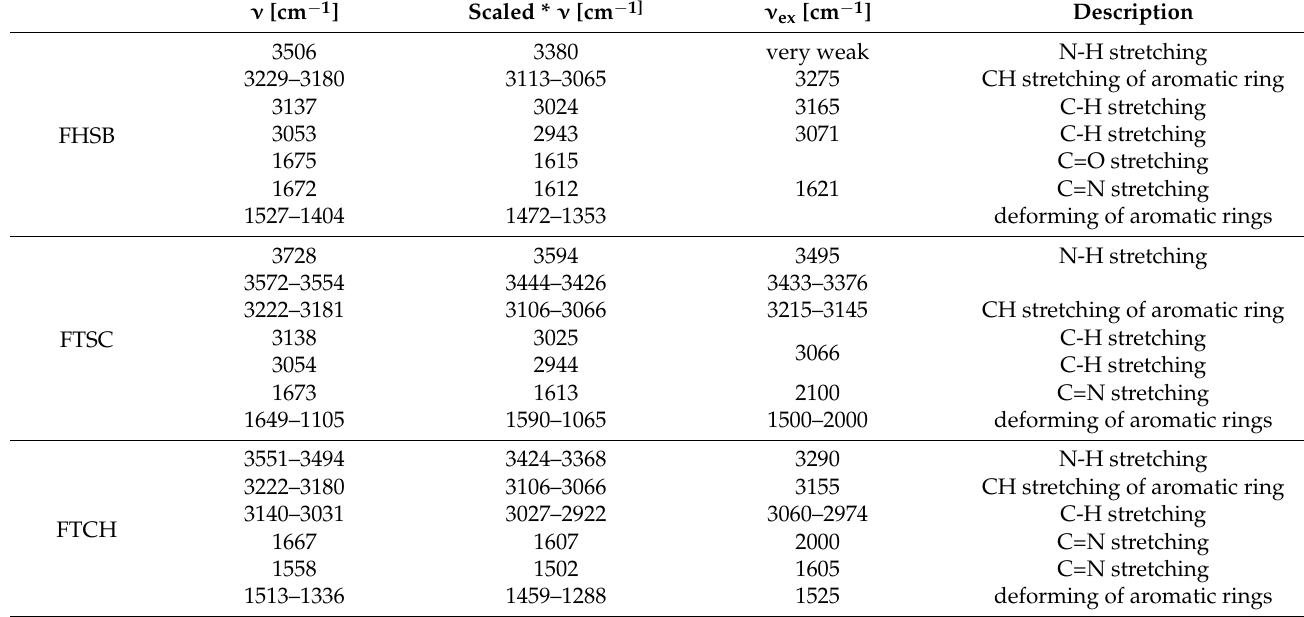
* Scaling factor for vibrational frequencies: 0.964 (Computational Chemistry Comparison and Benchmark DataBase).